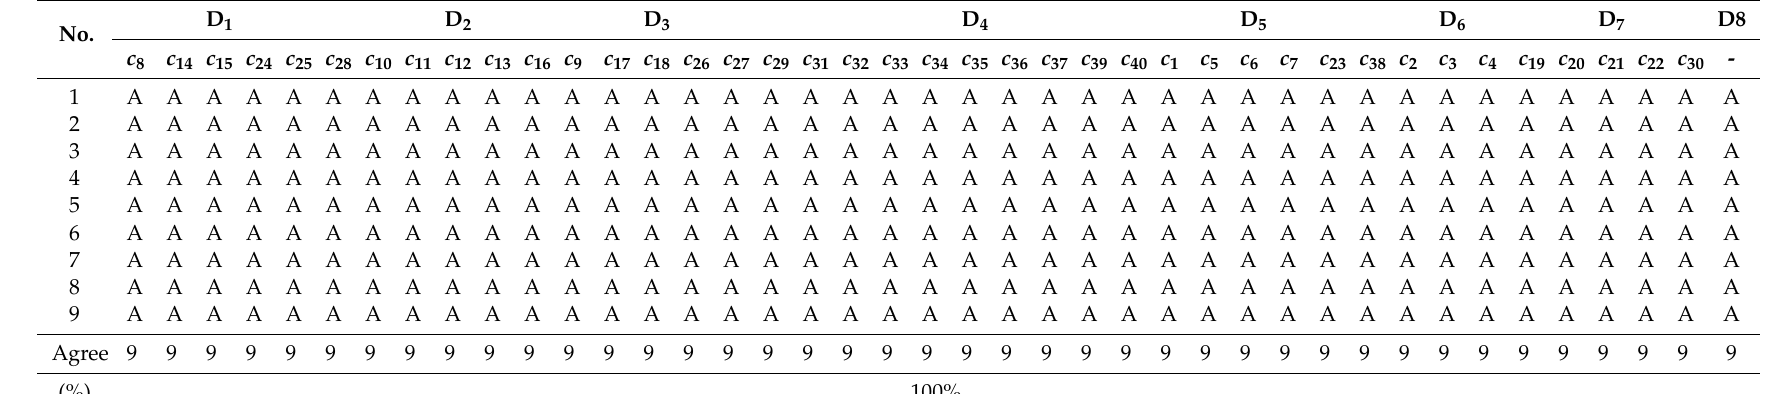
Table A1. Results being derived by Using the Modified Delphi